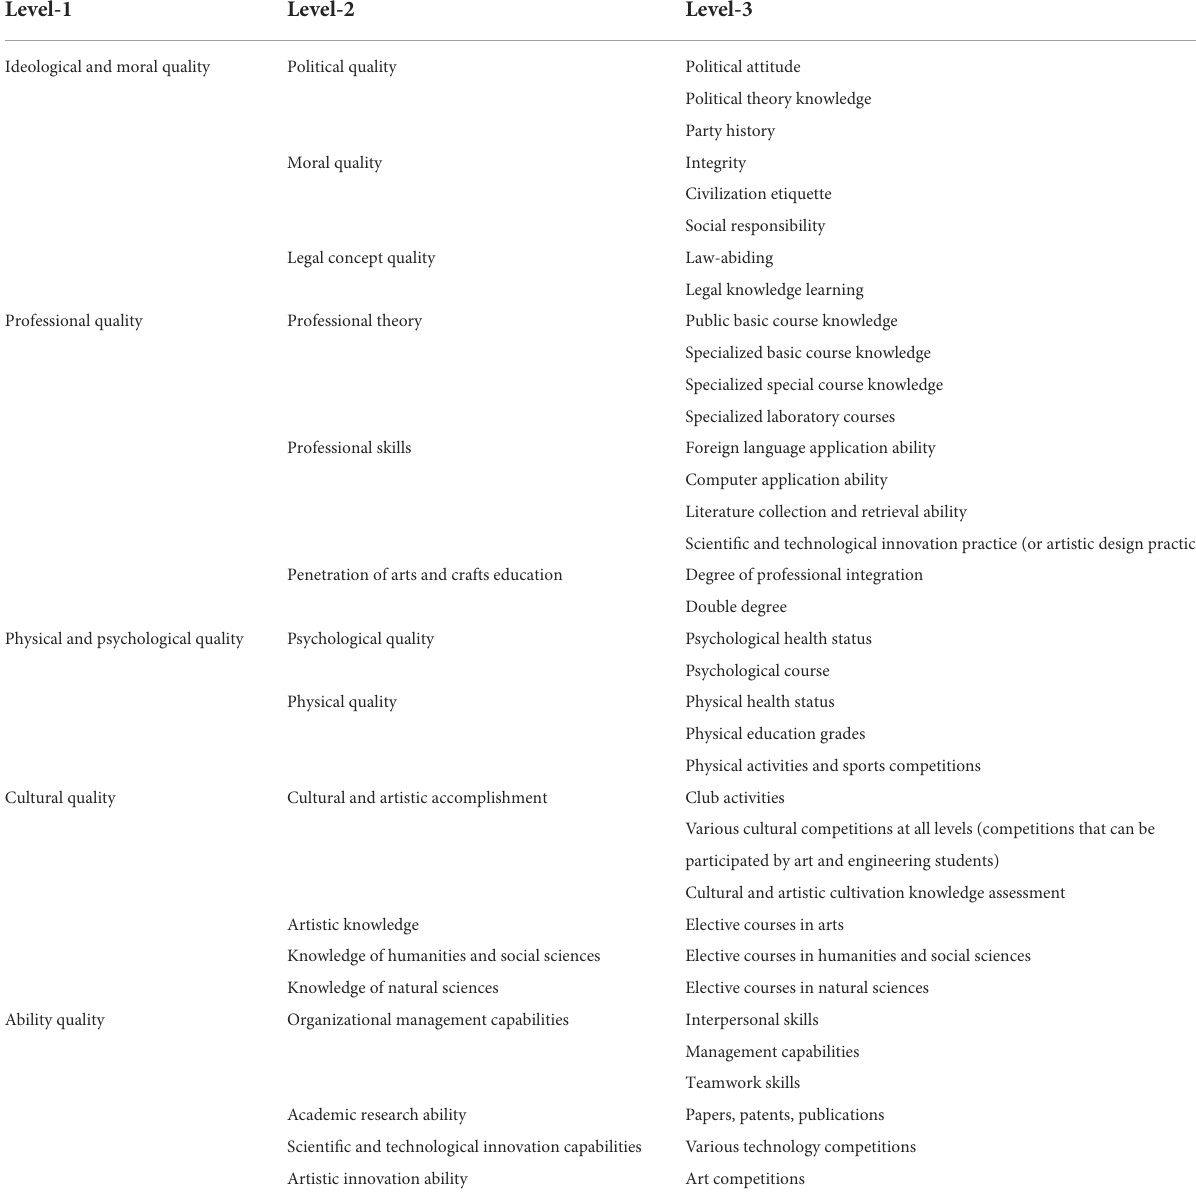
TABLE 1 Index system and collection